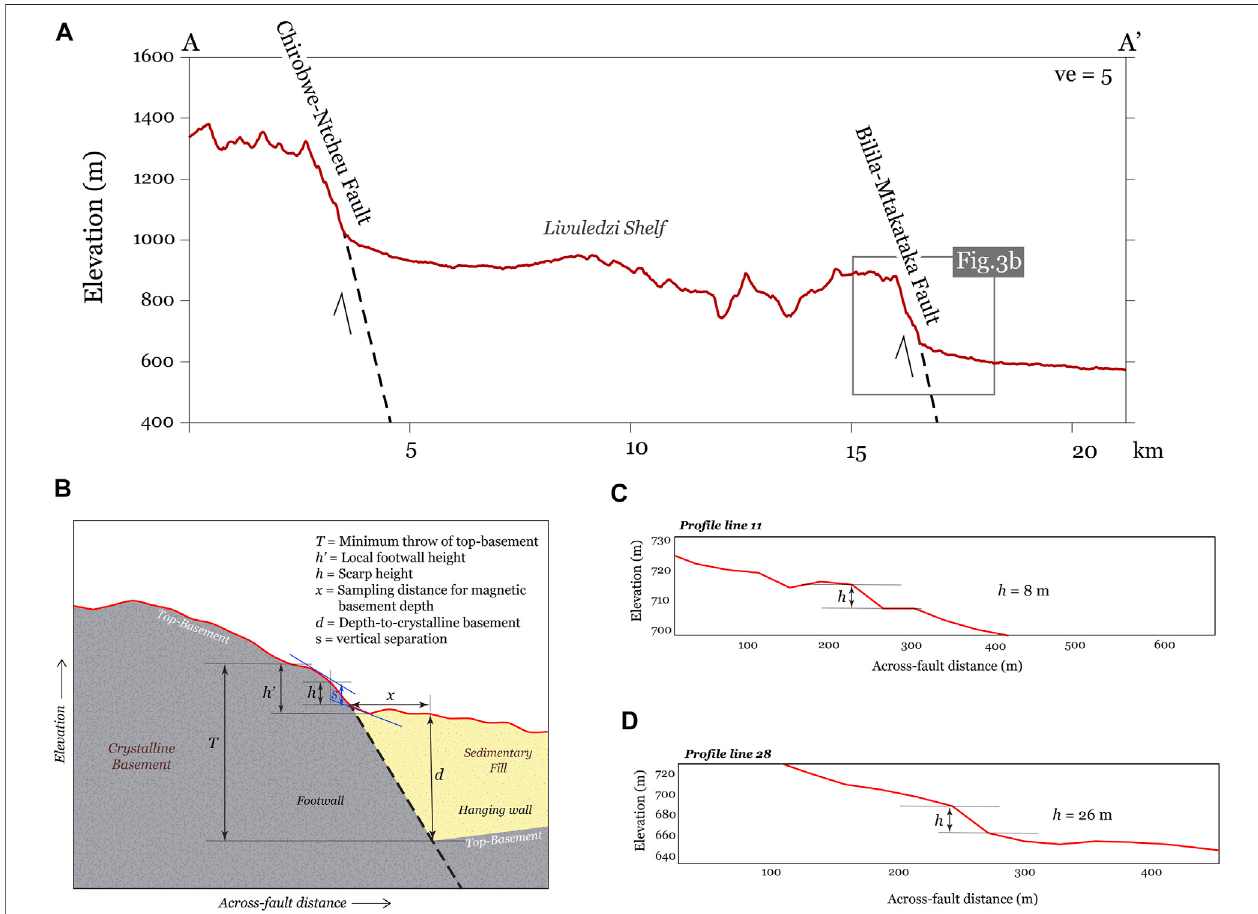
FIGURE 3 | (A) Elevation pro fi le across the Bilila-Mtakataka and the Chirobwe-Ntcheu faults. (B) How the minimum throw (T) was estimated from the measured scarp height (h) and corresponding points of extraction for aeromagnetic depth to magnetic basement (d). (C,D) examples of scarp height measurements.